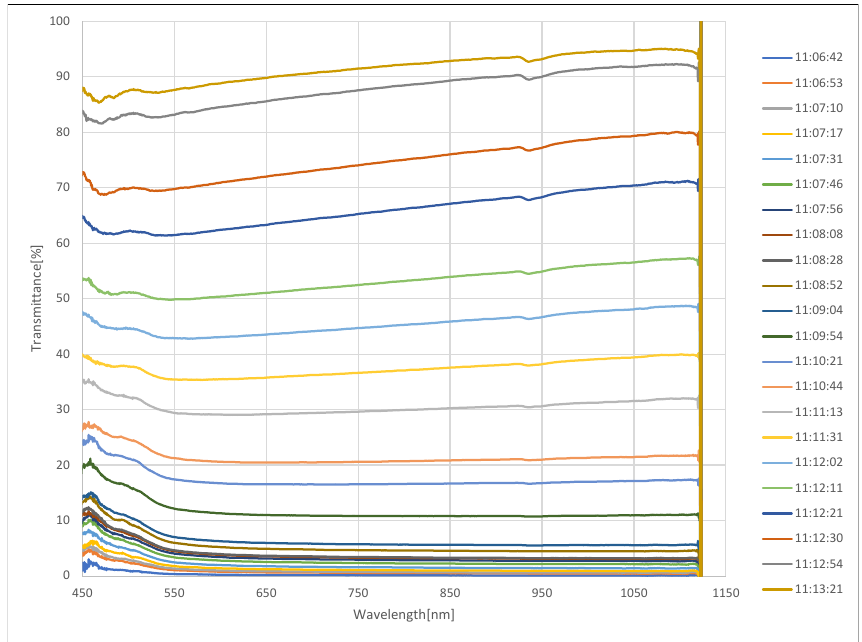
Figure 9. Spectral transmittance change according to the concentration of fog.